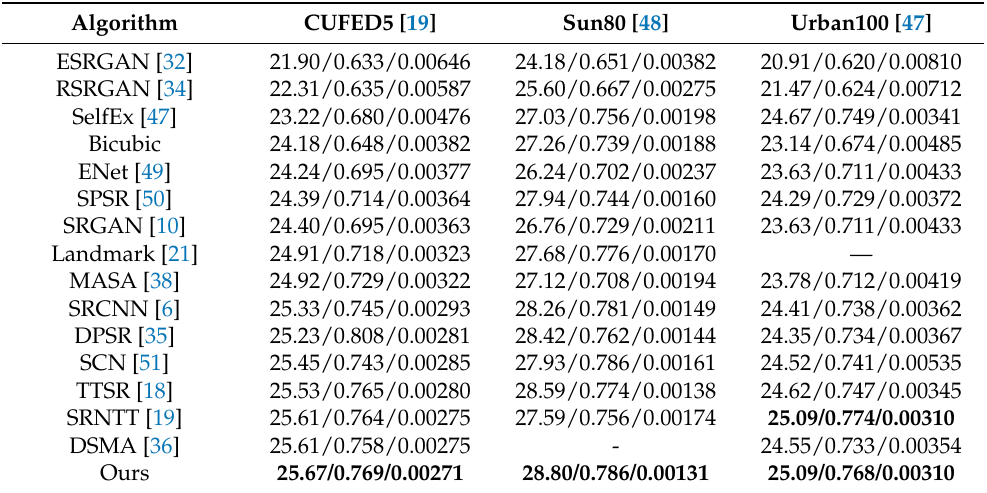
Table 4. PSNR/SSIM/MSE comparison of different super-resolution methods on three datasets. Bold numbers denote the highest scores. A lower MSE means better